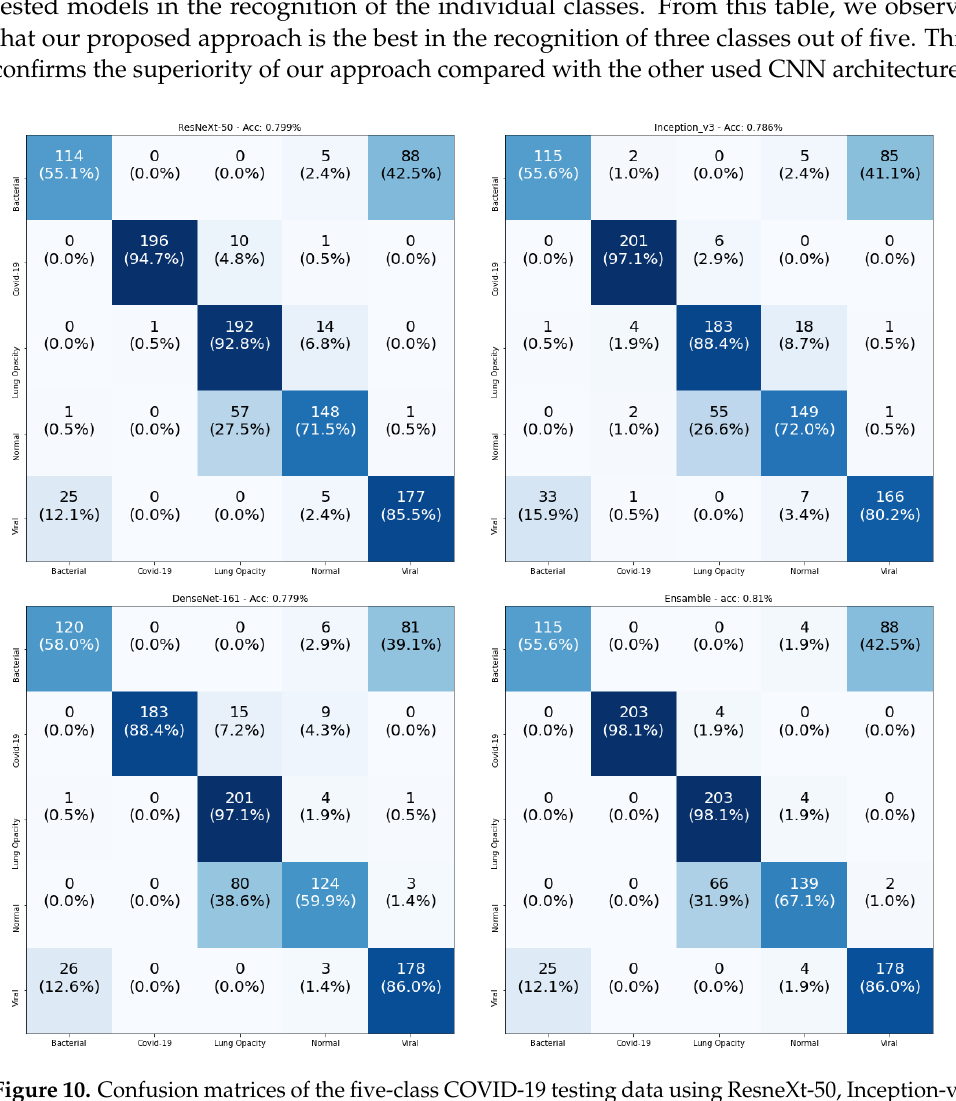
Figure 10. Confusion matrices of the five-class COVID-19 testing data using ResneXt-50, Inception-v3, DenseNet-161, and Ensemble-CNNs, respectively. The vertical axis is for the true classes and the horizontal axis is for the predicted